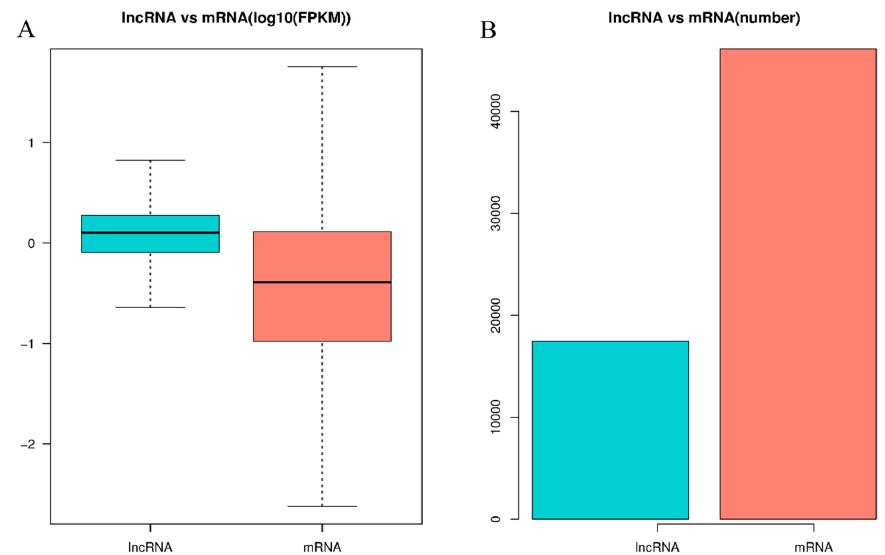
Figure 2. The expression levels and amounts of lncRNAs and mRNAs. ( A ) Boxplots of lncRNAs and mRNAs expression levels (with log10 FPKM method) in the high and low sperm motility groups. ( B ) The number of lncRNAs and mRNAs in testes with high sperm motility.